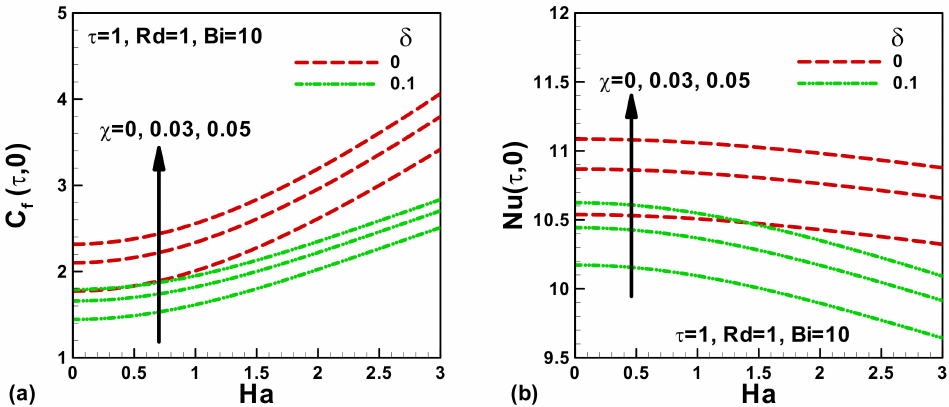
Figure 4. E ff ects of solid volume fraction of nanoparticles χ , magnetic Ha, and Navier slip δ parameters on ( a ) skin friction, and ( b ) Nusselt number when τ = 1.